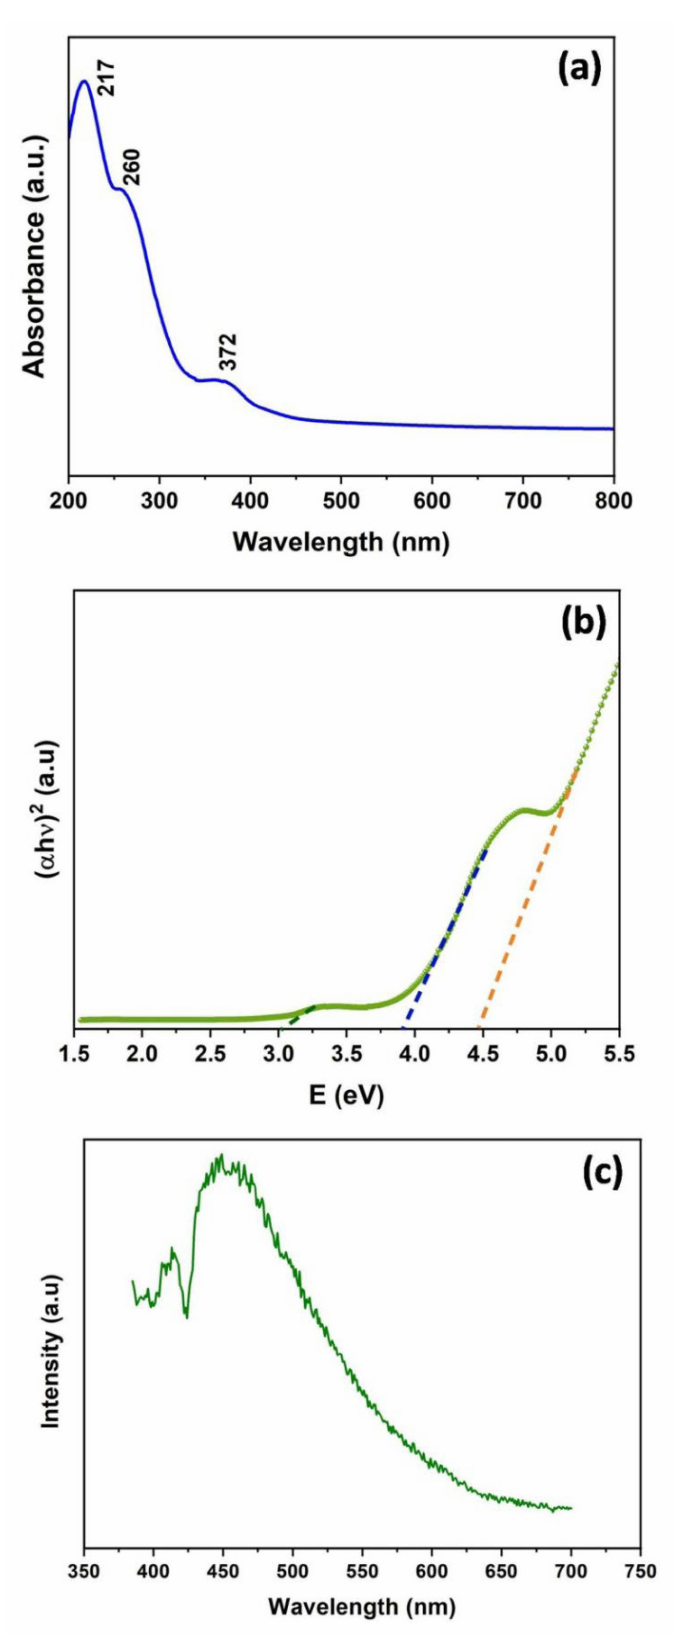
Figure 4. ( a ) UV-Vis absorption spectrum ( b ) Tauc plot ( c ) PL spectrum of the Zn(OH) 2 /ZnO bionanocomposite at the excitation wavelength 370